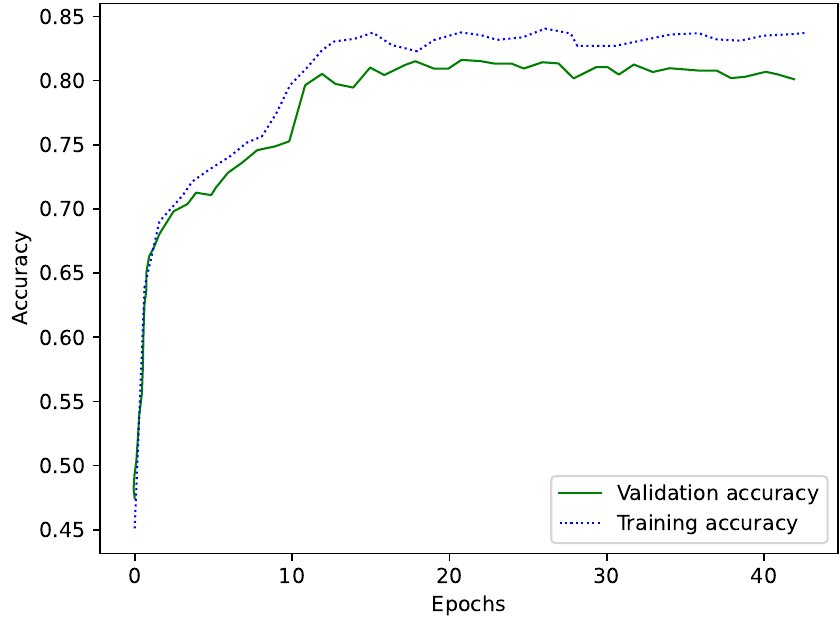
Figure 10. Training, validation accuracy iterative